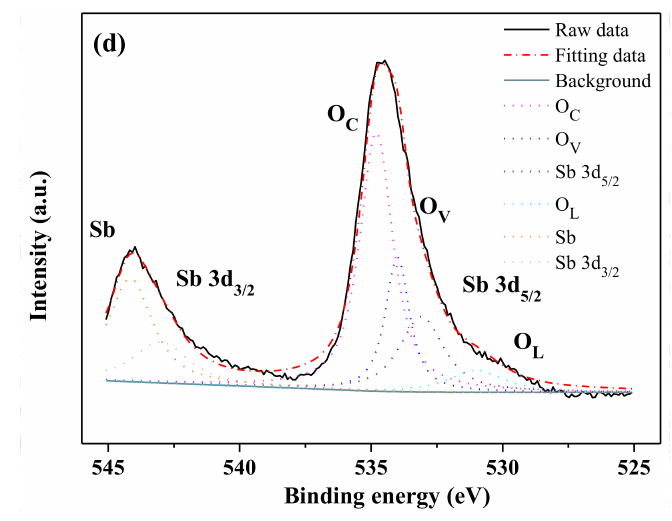
Figure 5. The XPS spectra of BiSnSbO 6 and every element in BiSnSbO 6 . The full spectrum of BiSnSbO 6 ( a ); Bi 4f ( b ); Sn 3d ( c ); Sb 3d and O1s ( d ). Table 1. The binding energies of the element characteristic peaks in the BiSnSbO 6